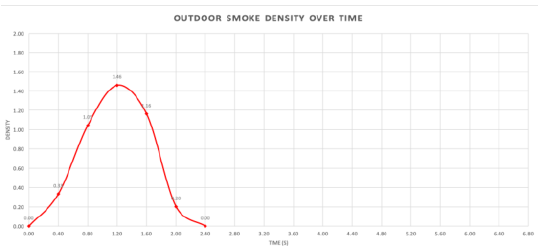
Figure 14. 2D Graph of Cigarette Smoke Density vs Time in an Outdoor Environment